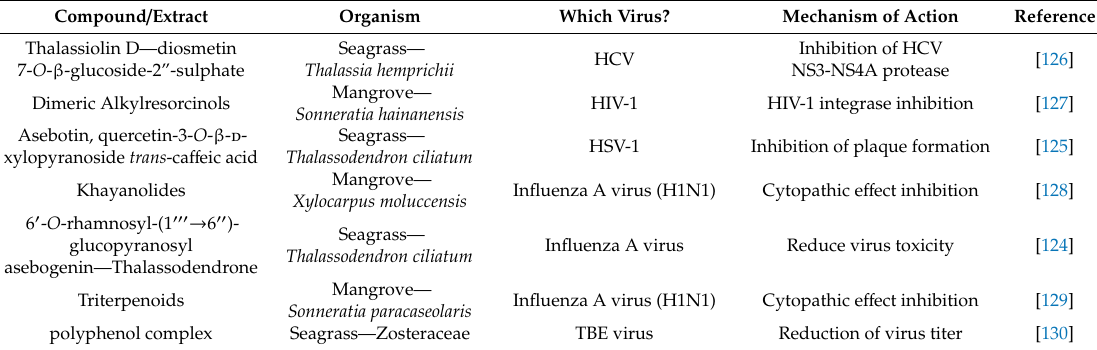
Table 5. The table report antiviral compounds / extracts from marine plants. HCV, Hepatitis C virus; HIV, Human Immunodeficiency virus; HSV-1, Herpes Simplex virus 1; TBE, Tick-Borne Encephalitis virus. Compound /